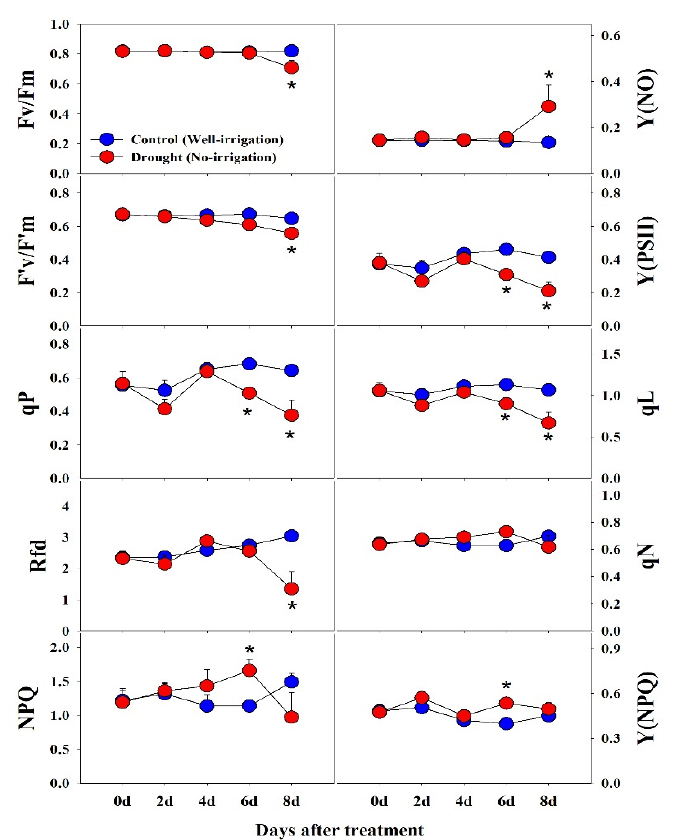
Figure 2. Changes in CF parameters in the seedlings of lettuce grown under drought condition at different time points. Each plot point represents the mean ± SD of 10 biological replicates. Asterisk (*) represents the significant difference between control and stressed seedlings in respective treatment time by one way ANOVA at p < 0.05. Refer to Table 1 for the description of each parameter.